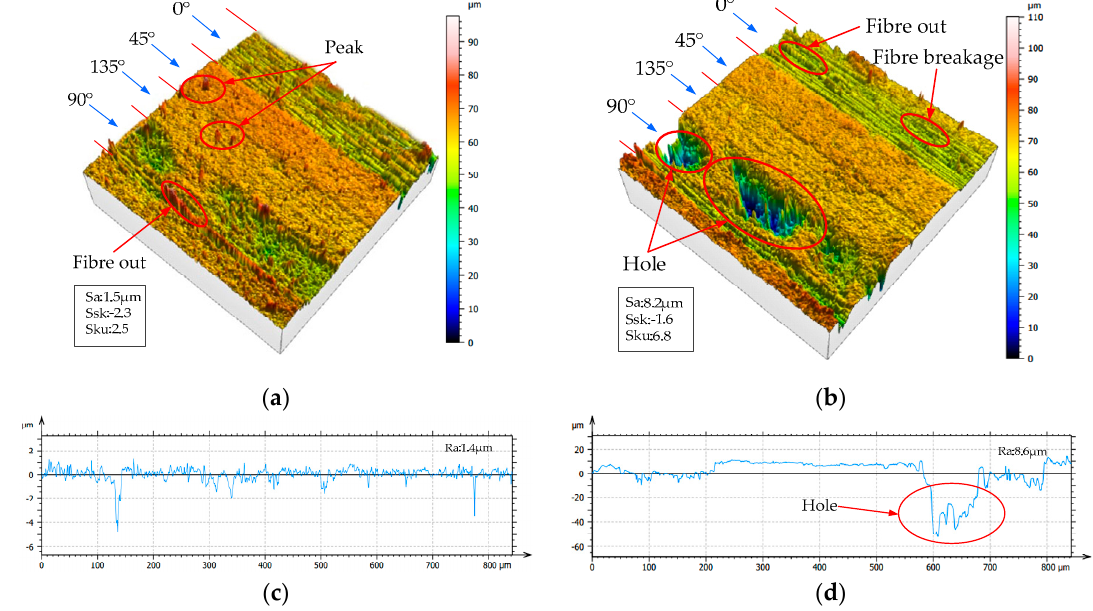
Figure 6. The surface topography of CFRP under various wear conditions: ( a ) 3D machining surface topography ( L : 3 m, R max : 23 µm); ( b ) 3D machining surface topography ( L : 51 m, R max : 61 µm); ( c ) 2D contour ( L : 3 m, R max : 23 µm); ( d ) 2D contour ( L : 51 m, R max : 61 µm).